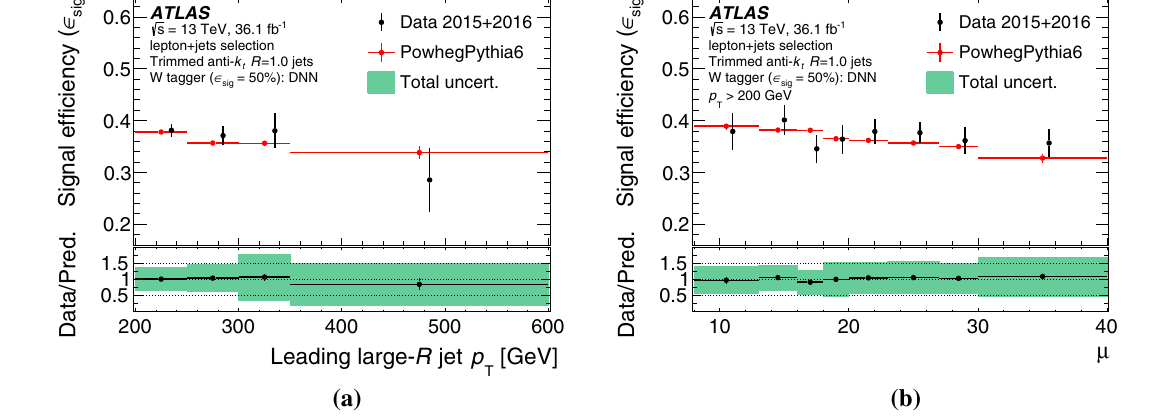
in data to that estimated in Monte Carlo is shown with statistical uncer- tainties as error bars on the data points and the sum in quadrature of statistical and systematic uncertainties as a shaded band. When consid- ering experimental uncertainties arising from the large- R jet, only those coming from the jet energy scale and resolution are